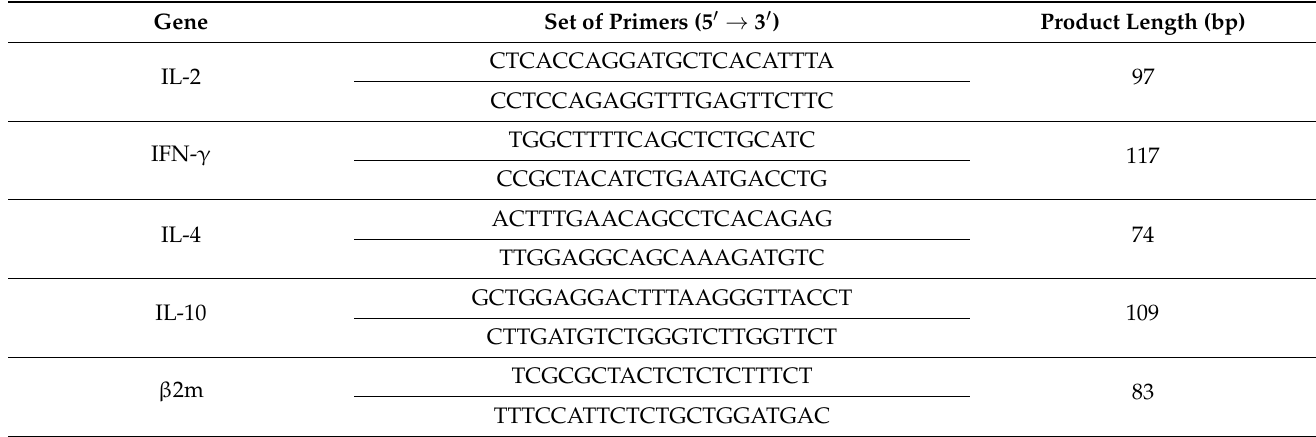
Table 2. PCR primer pairs used for the determination of cytokine gene expression.